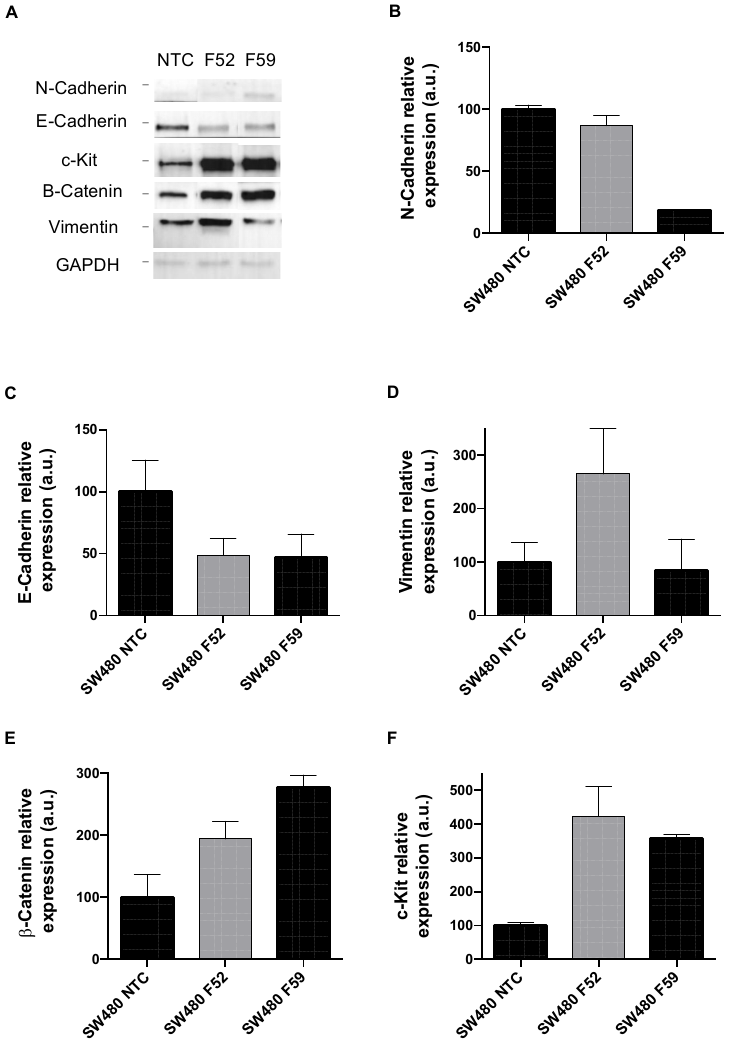
Figure 1. Impact of FUT8 downregulation on EMT markers in the SW480 cell line. ( A ): Representative image of protein levels of EMT markers analyzed by Western blot in SW480 NTC and FUT8 -silenced clones F52 and 59. ( B – F ): Relative quantification of N-cadherin, E-cadherin, c-Kit, β -catenin, and vimentin using GAPDH protein expression as loading control. Measurements were plotted as mean ± SEM of two replicates. NTC clones were used as reference for statistical analysis.